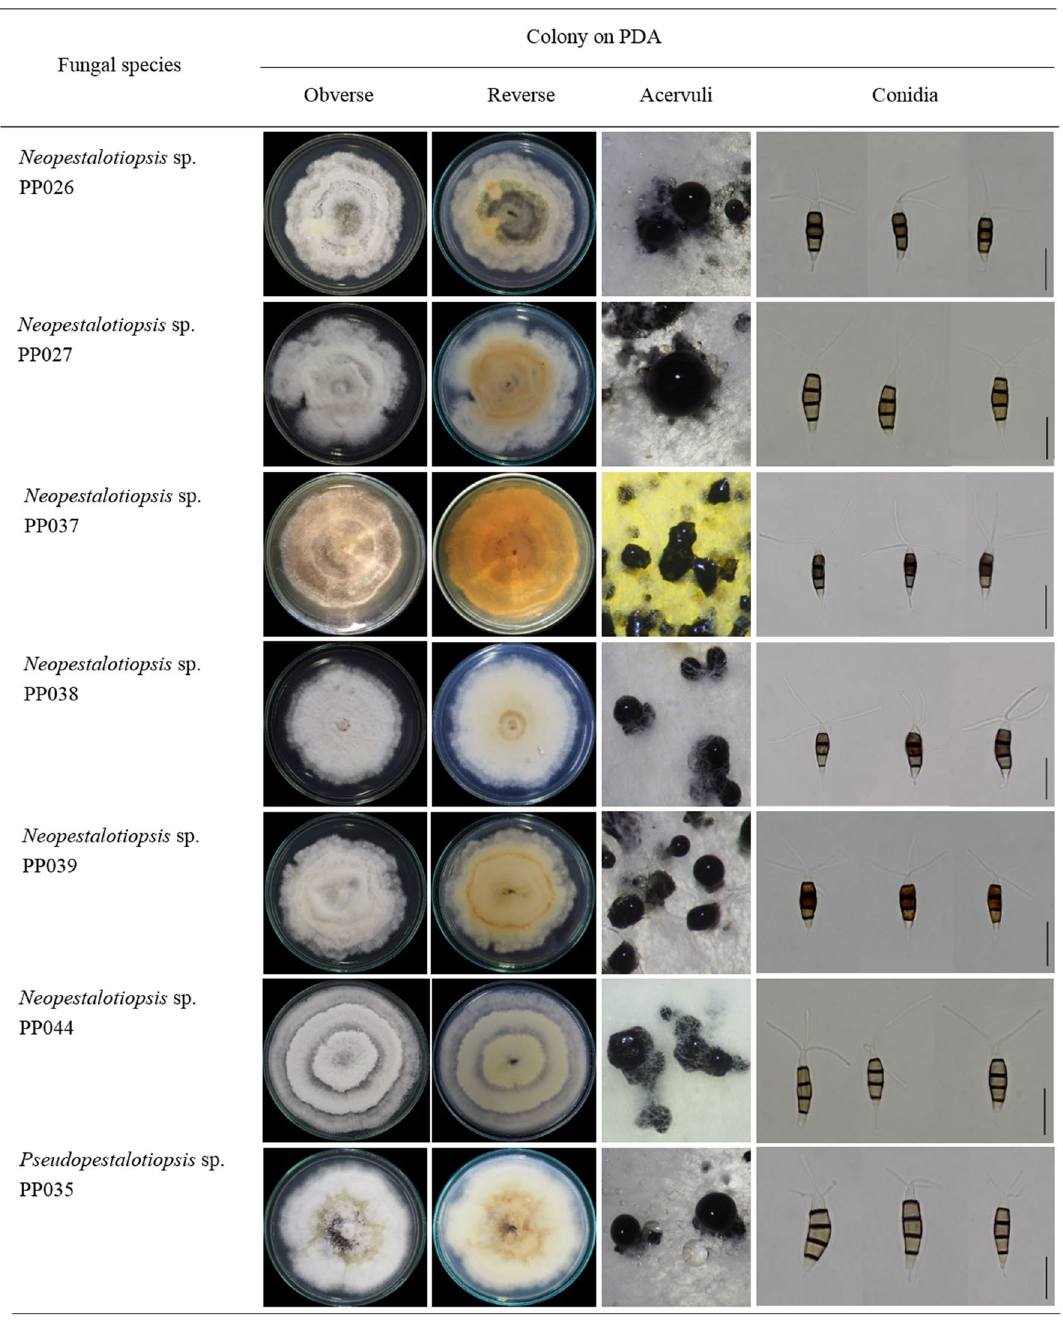
Figure 2. Morphological characteristics of Neopestalotiopsis and Pseudopestalotiopsis species cultivated on PDA for 7 days at 25 ± 2 °C. Scale bars represent 20